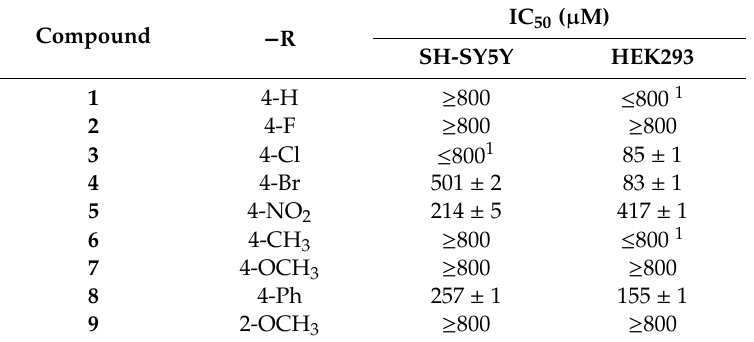
Table 3. Cytotoxicity of tested nicotinamide derivatives ( 1 – 9 ) on SH-SY5Y and HEK293 cell line expressed as IC 50 values ( µ M). Experimental data was presented as a mean of at least three experiments with standard error. R denotes substituent and its position on the phenyl ring. IC 50 ( µ M) Compound − R SH-SY5Y HEK293 1 4-H ≥ 800 ≤ 800 1